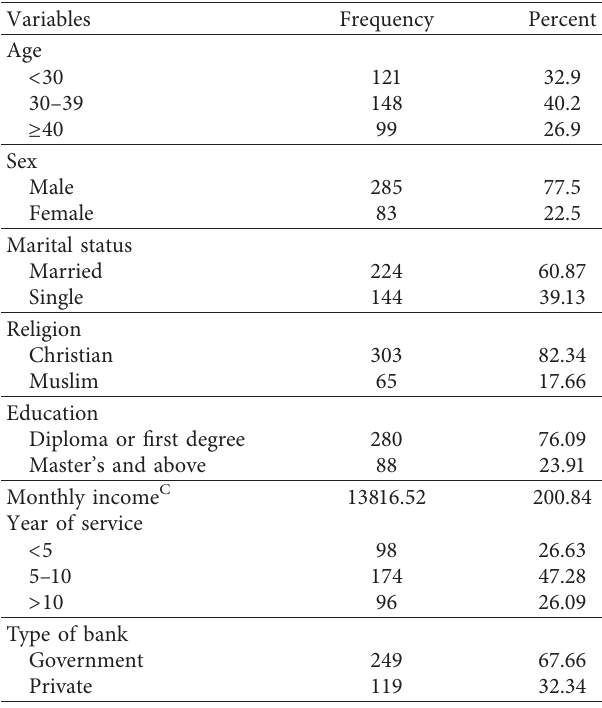
Table 1: Sociodemographic characteristics of bank employees